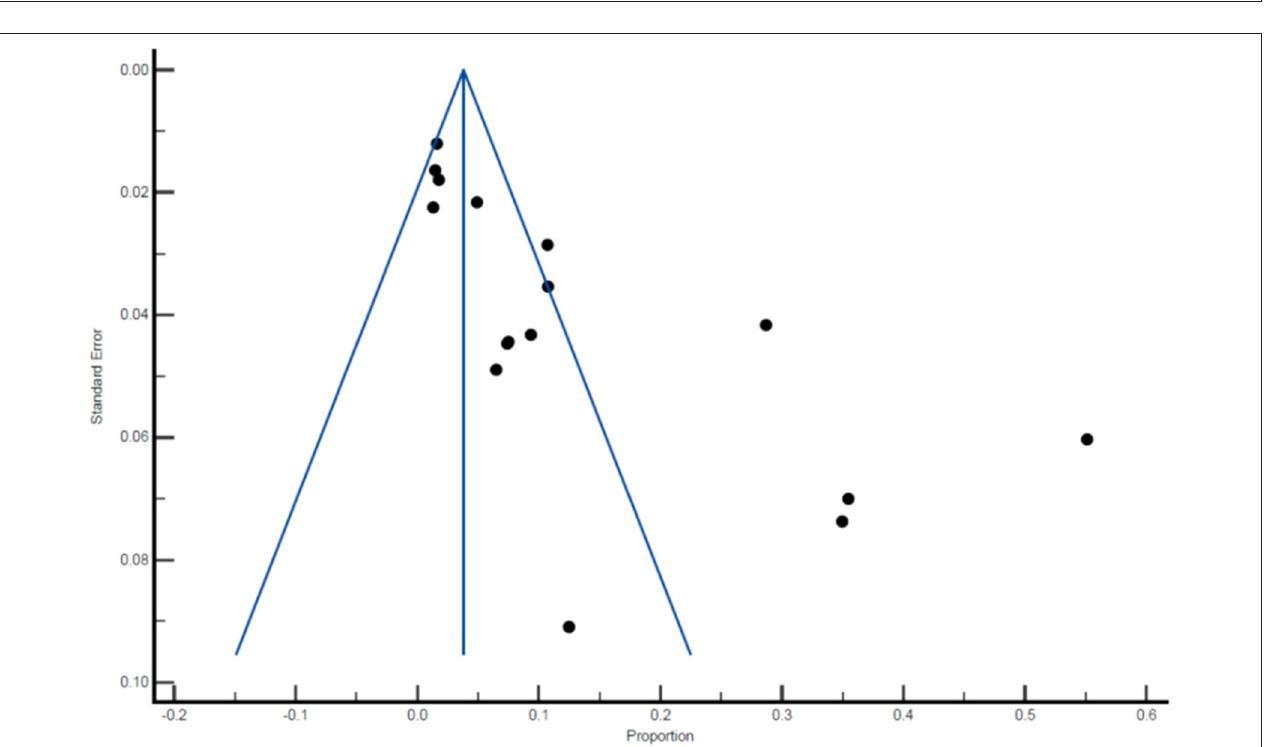
FIGURE 6 | Funnel plot of the prevalence of malaria among pregnant women.